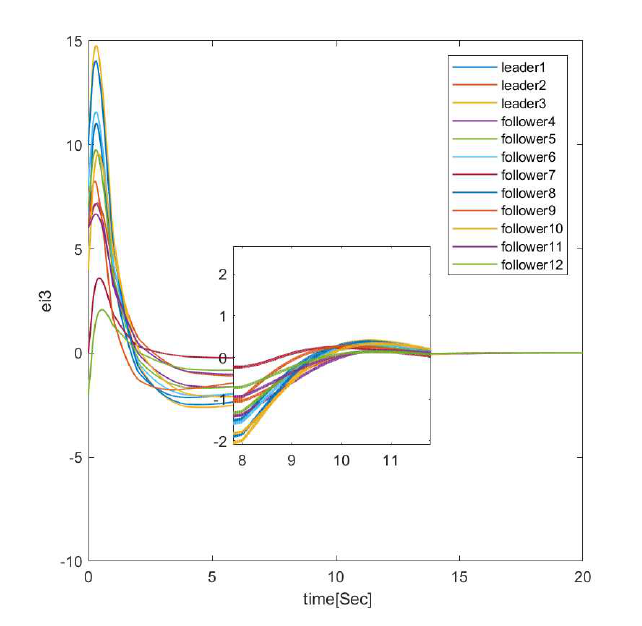
Figure 8. Position State Component 3 of Agent with hierarchical delay.